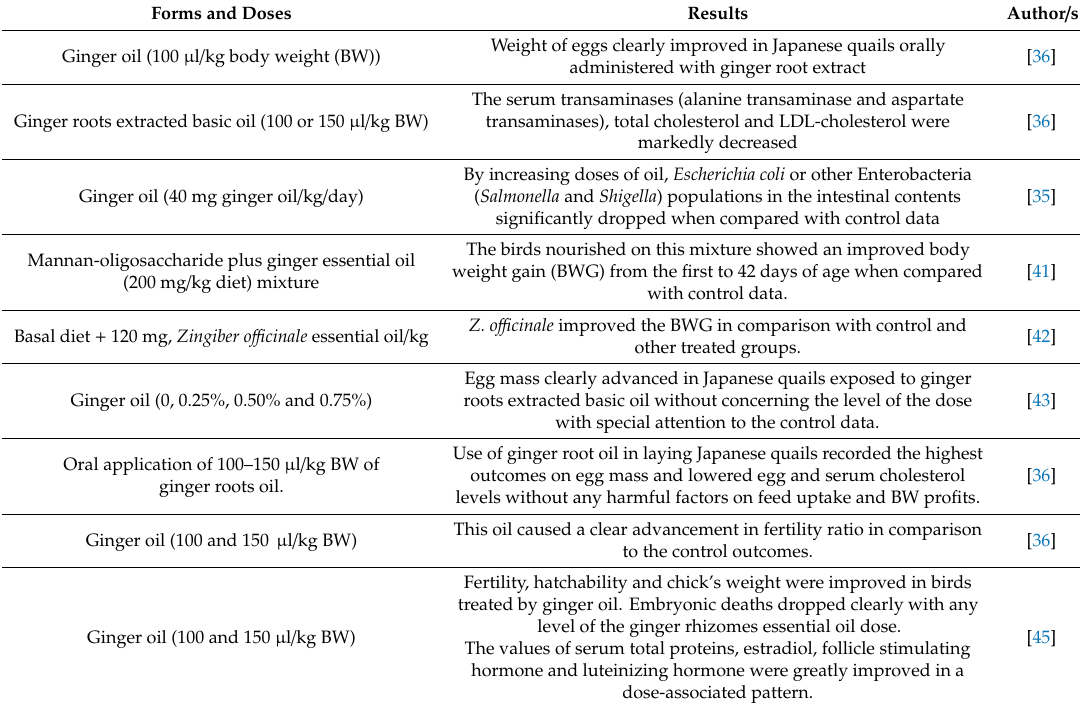
Table 1. Beneficial e ff ects of ginger and its derivatives in poultry